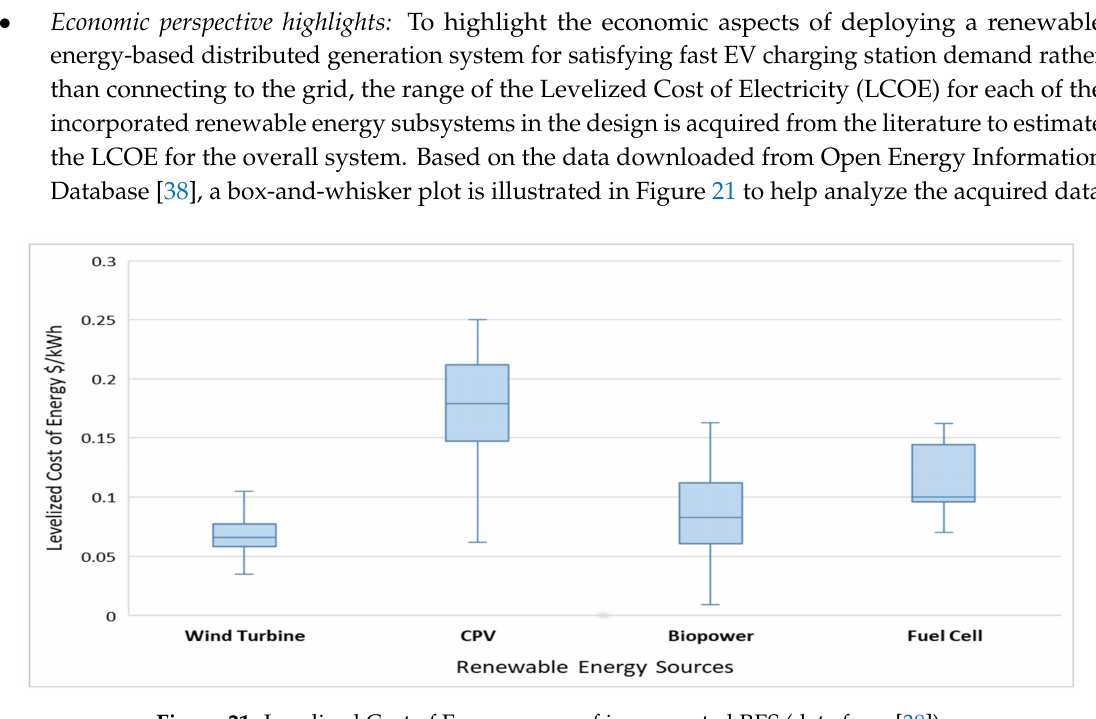
Figure 21. Levelized Cost of Energy range of incorporated RES (data from